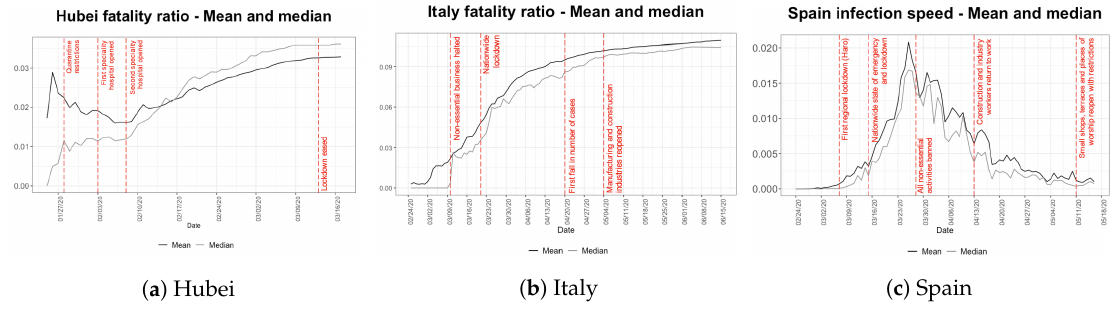
Figure 11. Time series plots for mean and median fatality